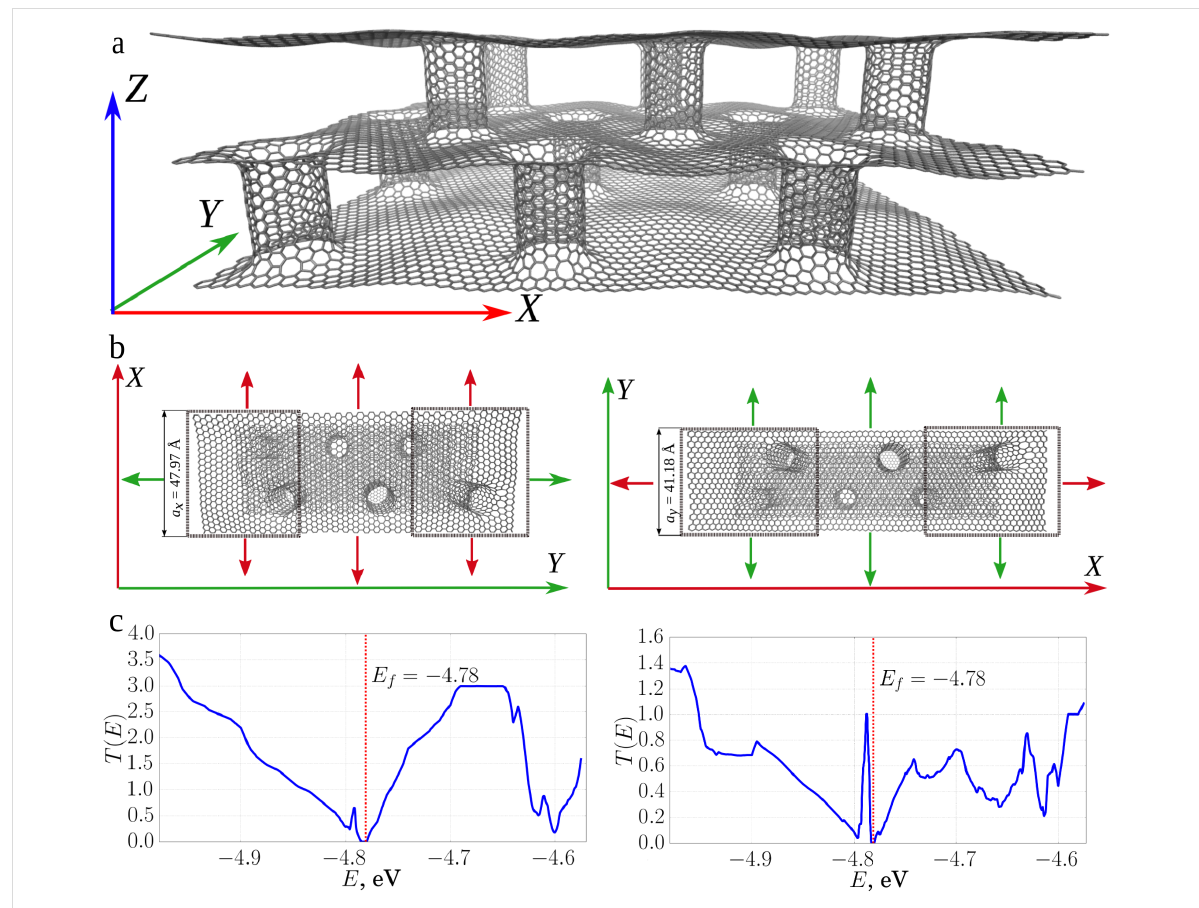
Figure 6: Two-layer 2D composite of pillared graphene based on CNT (9,9) with a length of 2.4 nm: a) atomic structure; b) schematic representation of the cell of the composite and electrodes in electronic transport along X (left) and along Y (right); c) transmission functions along the X - (left) and Y - (right) directions.